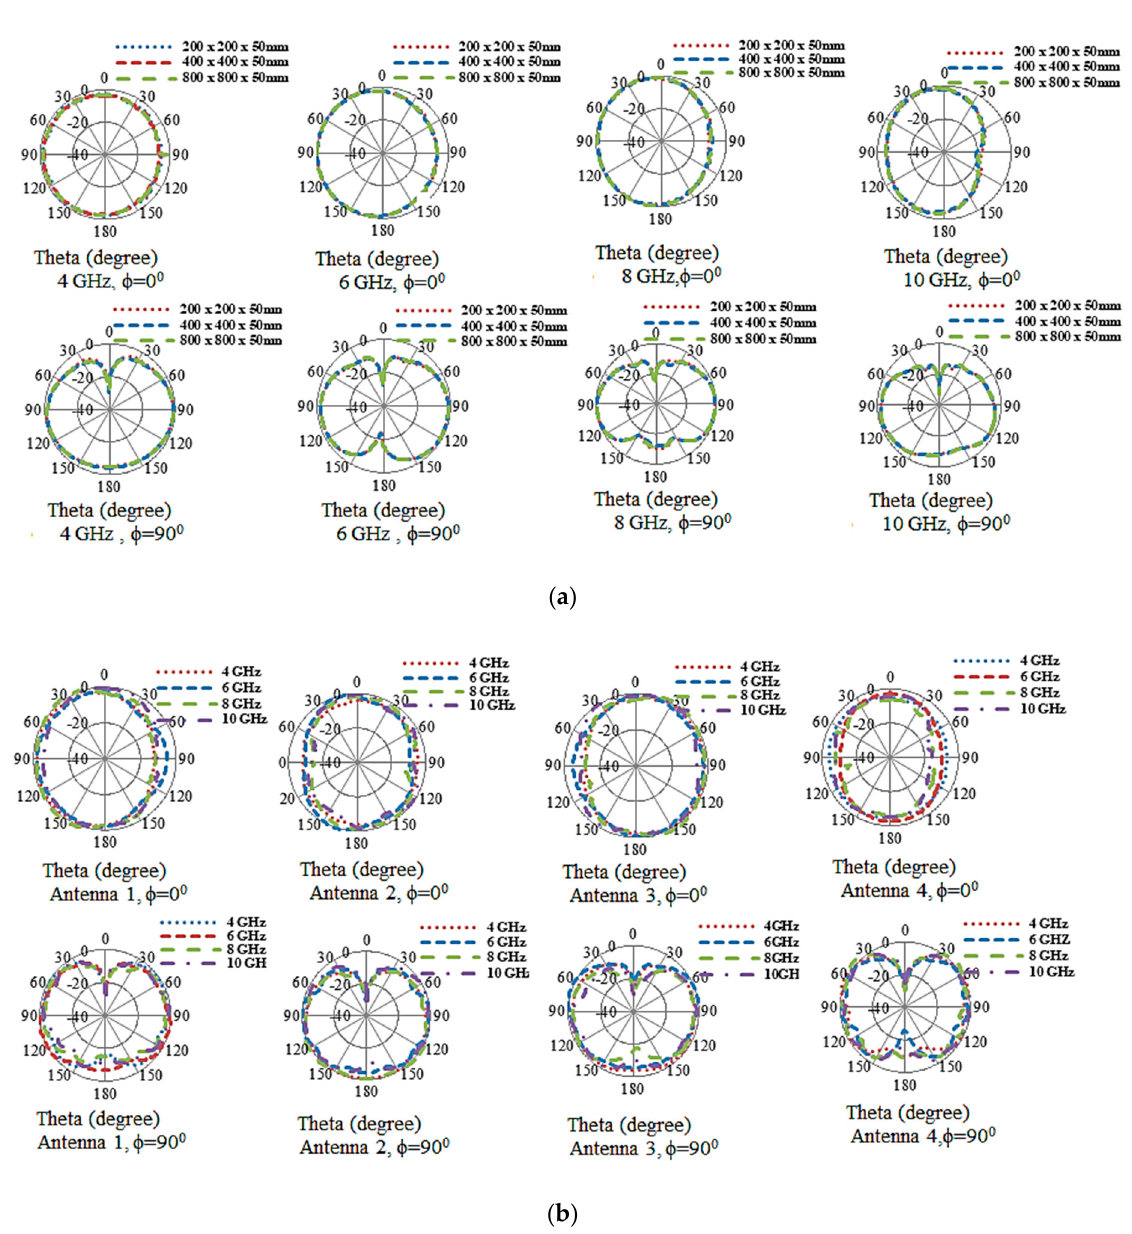
Figure 12. The unit antenna element/MIMO antenna radiation patterns when the housing effect is taken into account ( a ) single antenna element in the y - z and x - z planes on different sized metal plates ( b ) MIMO antenna in the y - z and x - z planes on a metal plate of 800 mm × 800 mm × 50 mm.